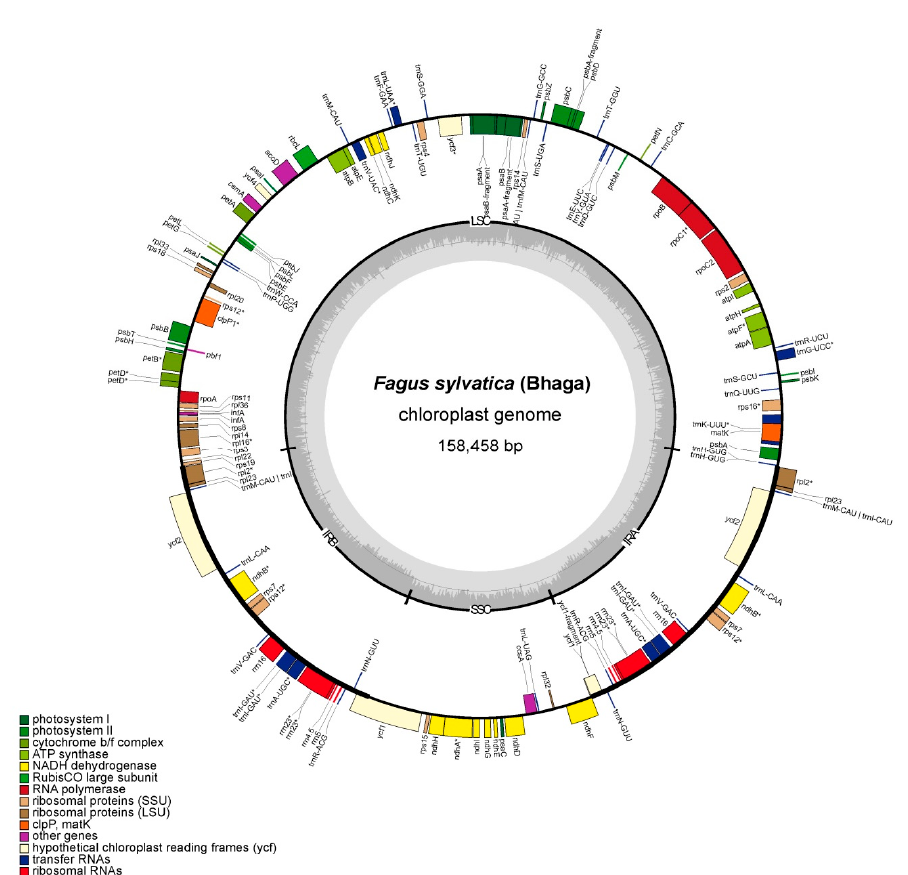
Figure 1. Circular chloroplast of Fagus sylvatica (Bhaga) with gene locations on both strands, along with an indication of the locations of the inverted repeat regions and the large and the small single-copy regions.